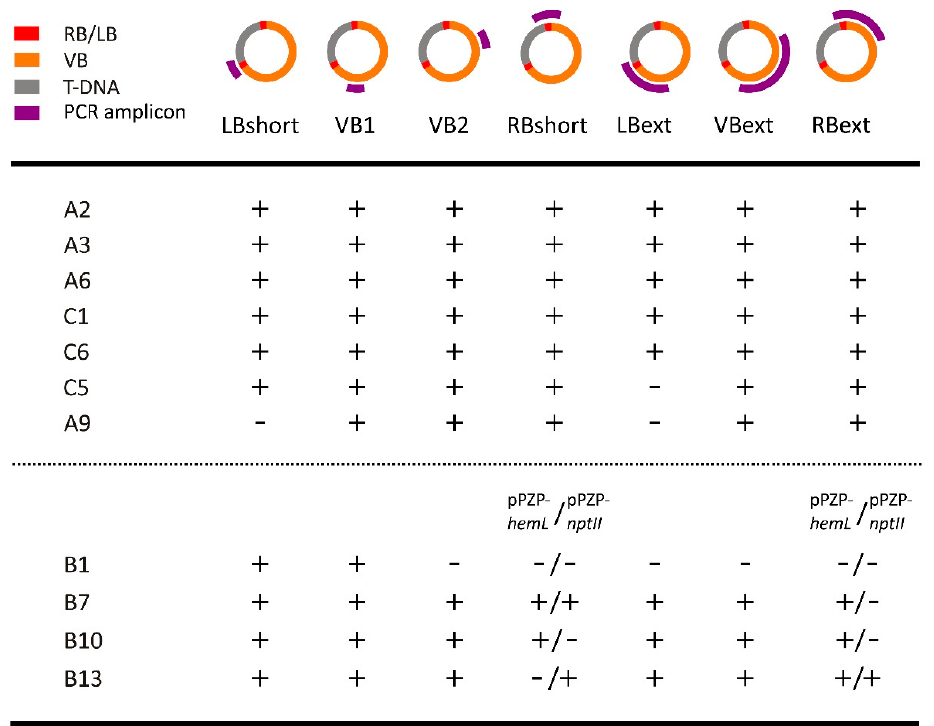
Figure 3. Summary of PCR screening results for the detection of vector backbone (VB) sequences in selected transgenic events of alfalfa. For the transgenic events produced by a co-transformation experiments (B1, B7, B10, B13) two columns are present for the amplicons RBshort and RBext to account for the two binary vectors used in the experiment (pPZP- hemL , pPZP- nptII , Figure S3). +, PCR positive; − , PCR negative.